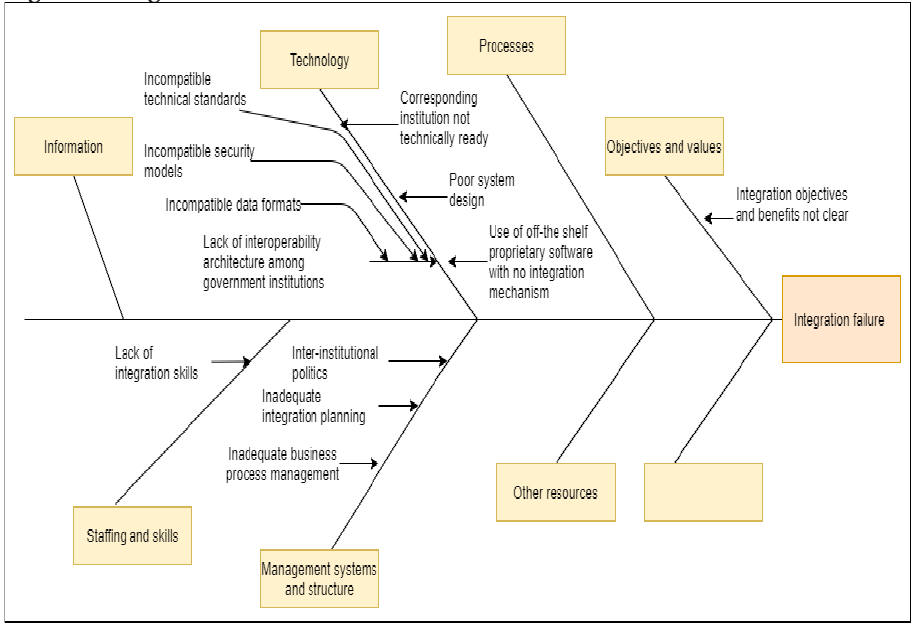
Figure 8: Integration